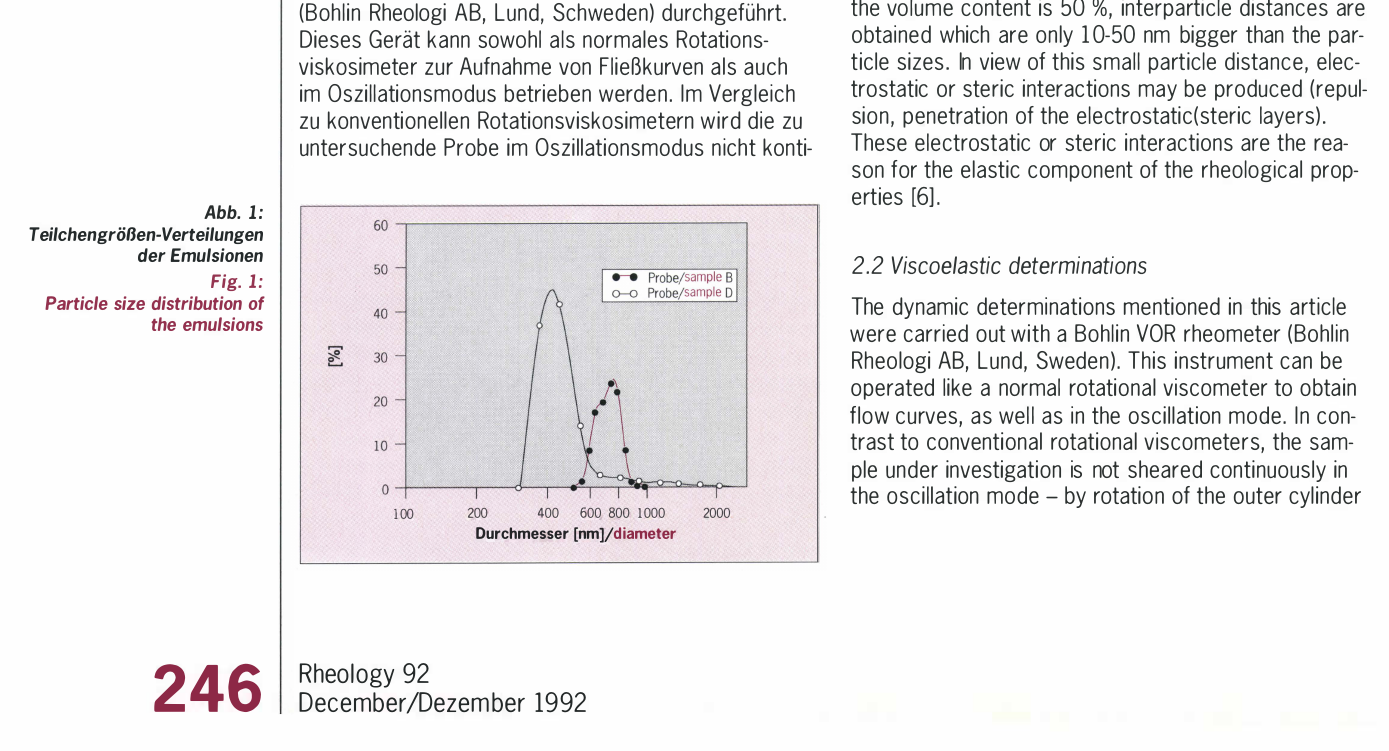
Particle size distribution